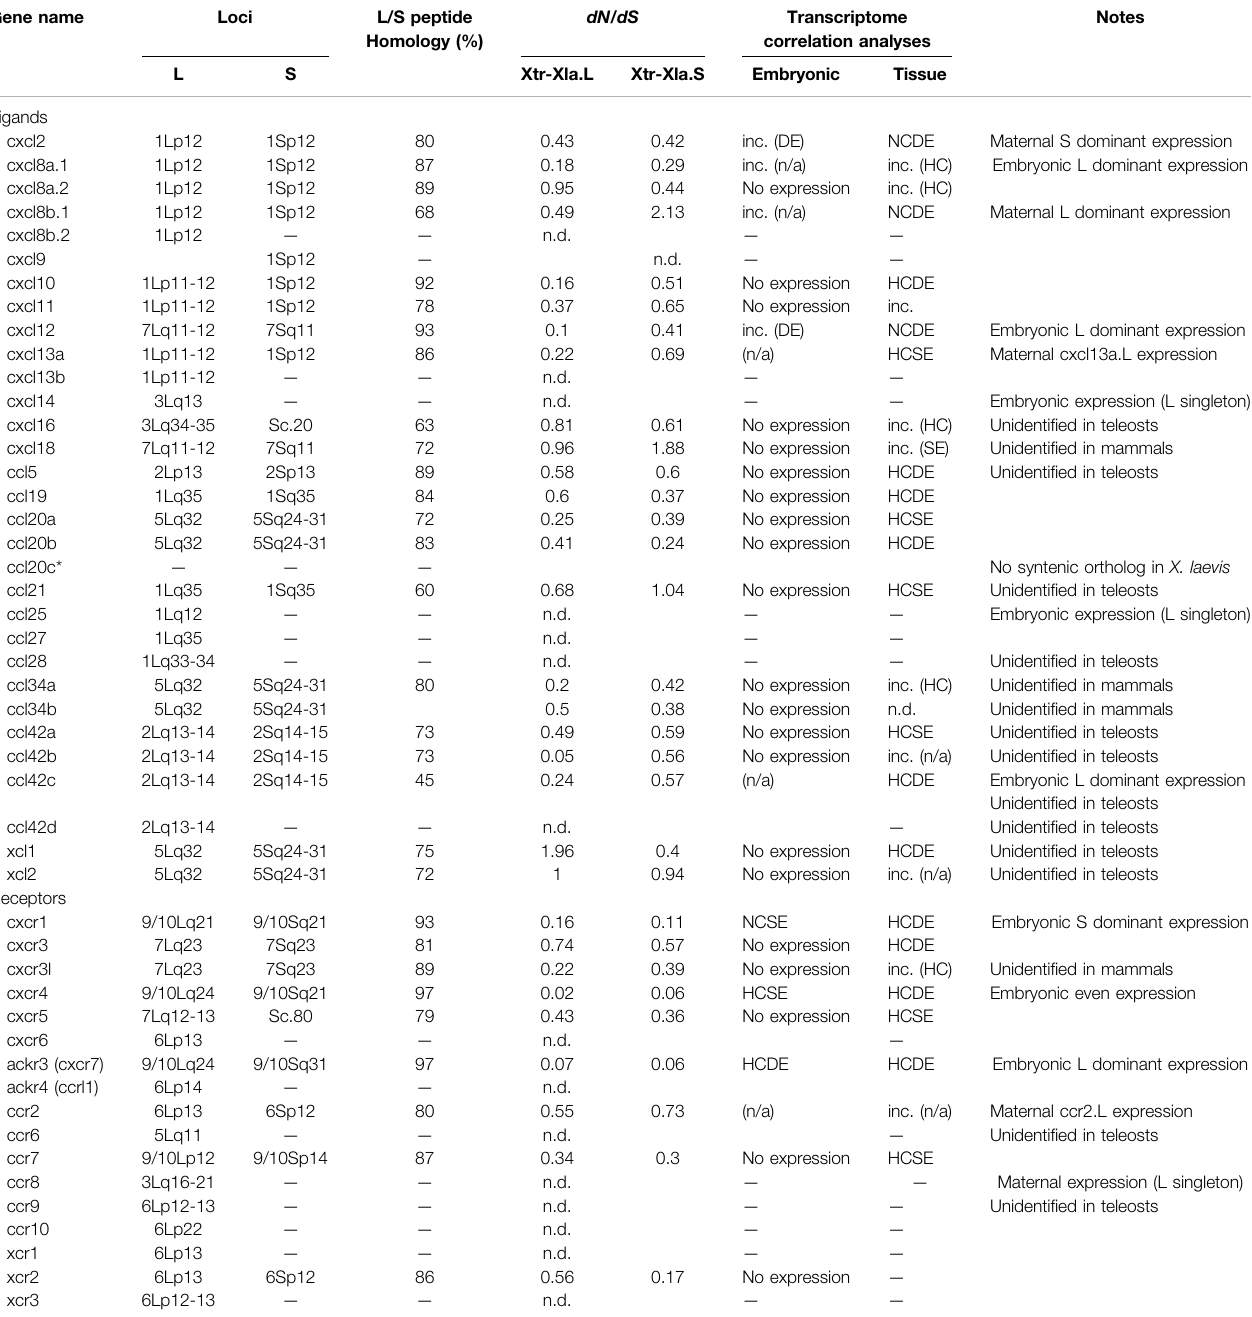
TABLE 1 | Review of chemokine ligands and receptors in Xenopus laevis . Loci were estimated by the closest locus of FISH results demonstrated in Session et al. (2016). Orthologies were obtained from molecular phylogenetic analysis and syntenic analysis. Peptide sequence homology between L and S homeologous genes was calculated by CLUSTAL omega using full-length predicted peptide. Columns of transcriptome correlation analyses show the categories of HC: high correlation; NC: no correlation; SE: same expression levels; DE: different expression levels. “ inc. ” indicates inconsistent categories (see Materials and Methods). Note that cxcl16, ccl5, ccl21, ccl28, ccl42a, ccl42b, ccl42c, ccl42d, xcl1, xcl2, ccr2, and ccr8 genes are unidenti fi ed in teleosts, and cxcl18, ccl34a, ccl34b, and cxcr3l genes are unidenti fi ed in mammals (Nomiyama et al.,